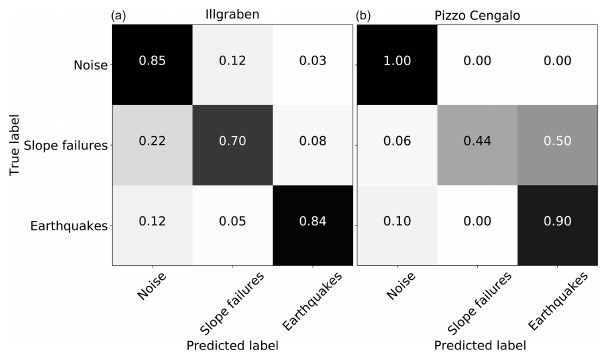
Figure 5. Confusion matrices of an initial test of the continuous random forest approach on 20s windowed data. (a) Illgraben data set, (b) Pizzo Cengalo data